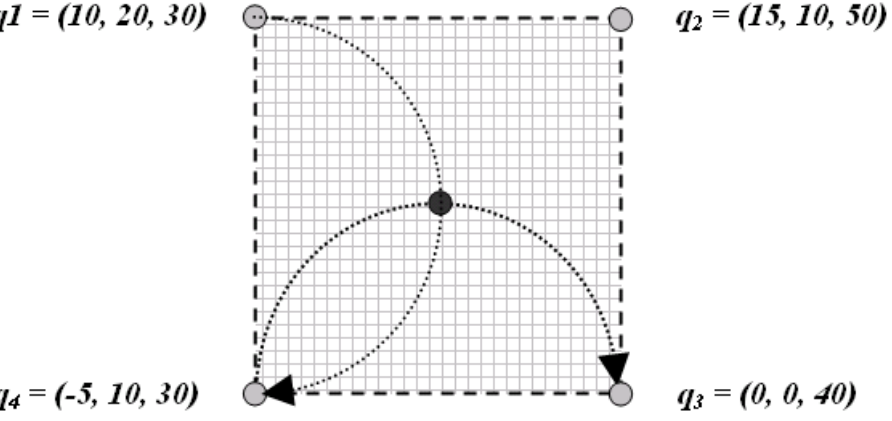
Figure 10. DTPM single cell with two spherical and quadrangle (SQUAD) sequences given as parabola-motion form (arcs)—orientation nodes q in